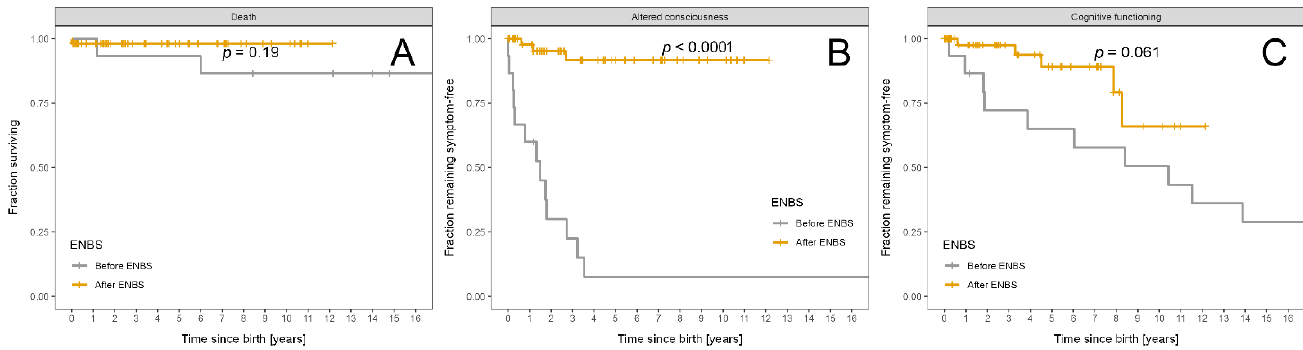
Figure 5. Fraction of MCADD patients remaining alive and symptom free: Patients diagnosed before ENBS ( n = 15) are shown as grey and patients diagnosed after ENBS ( n = 54) as orange curves, respectively. ( A ) Survival probability. ( B ) Absence of any episode of altered consciousness. ( C ) Absence of cognitive impairment. Kaplan–Meier estimator was used; p designates significance of difference between the cohorts.